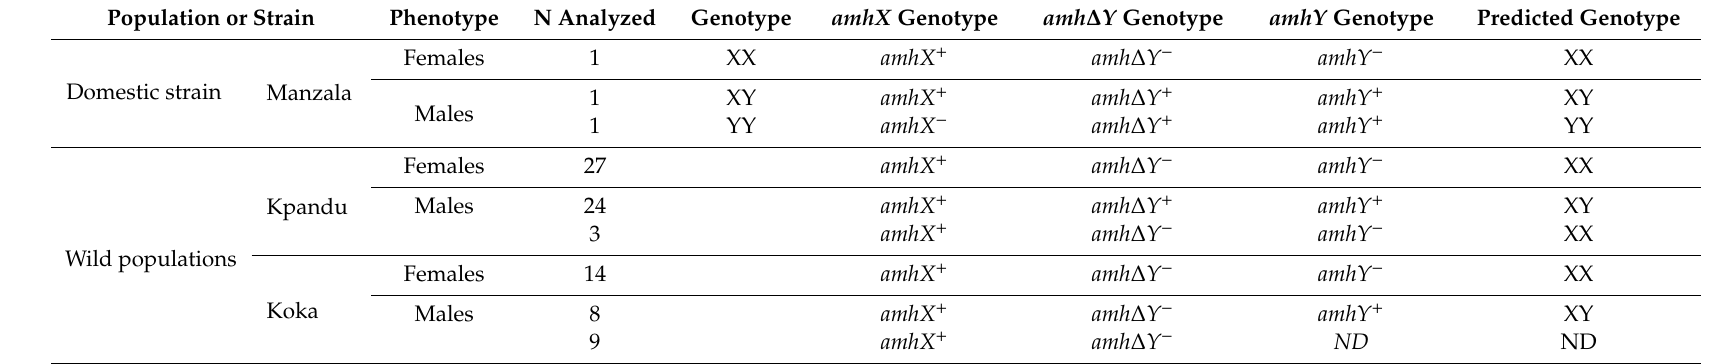
Table 2. Sex chromosomic LG23 amh markers analysed in the Kpandu and Koka wild-caught fish to predict the sexual genotype. The Manzala strain with known sex genotypes was used to validate the